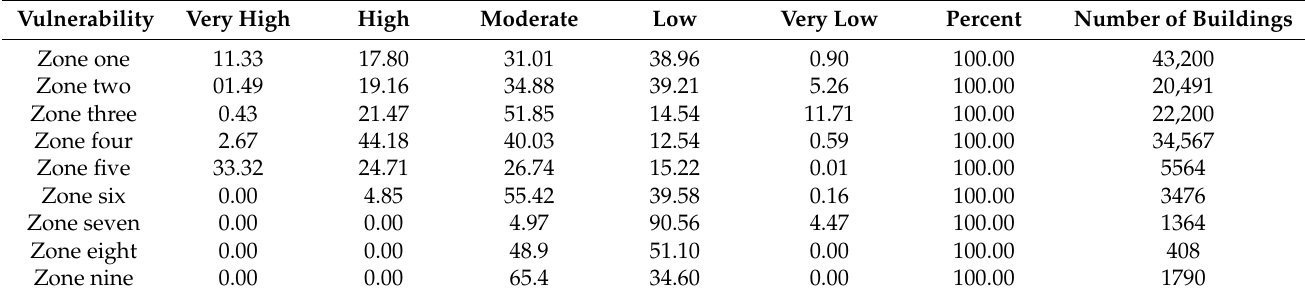
Table 10. Assessment of Residential Building Vulnerability (RBV) in Tabriz according to the MLP method. Vulnerability Very High High Moderate Low Very Low Percent Number of Buildings Zone one